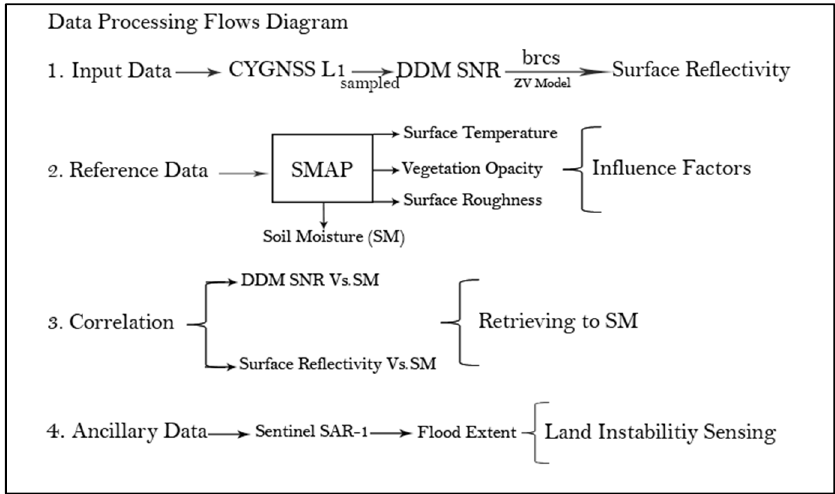
Figure 7. Processing flows of CYGNSS and SMAP for regional soil moisture sensing.